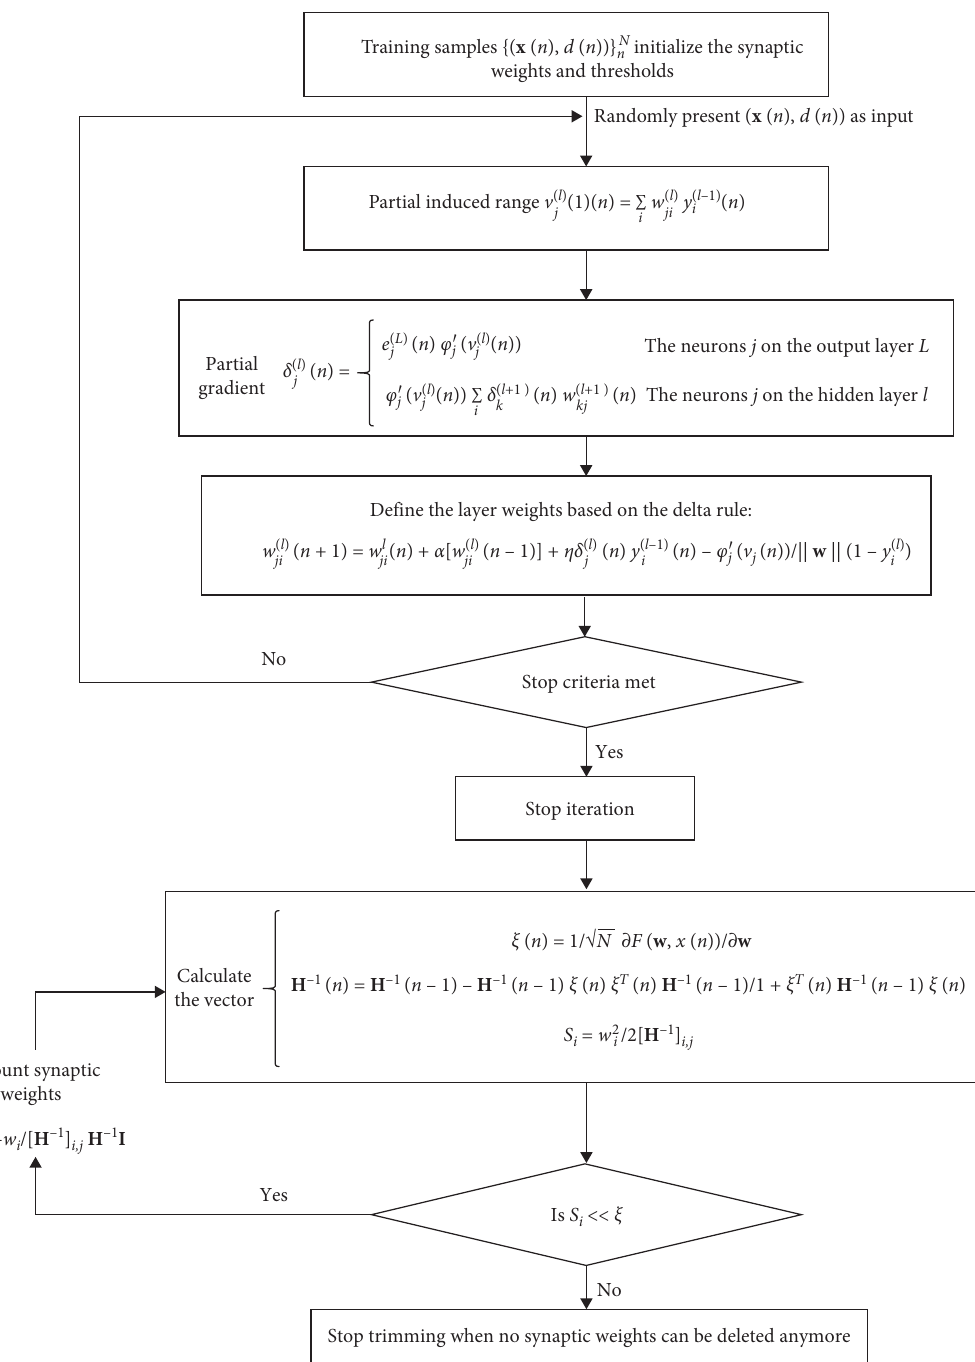
Figure 2: The regularized network training algorithm based on the sensitive area of Sigmoid